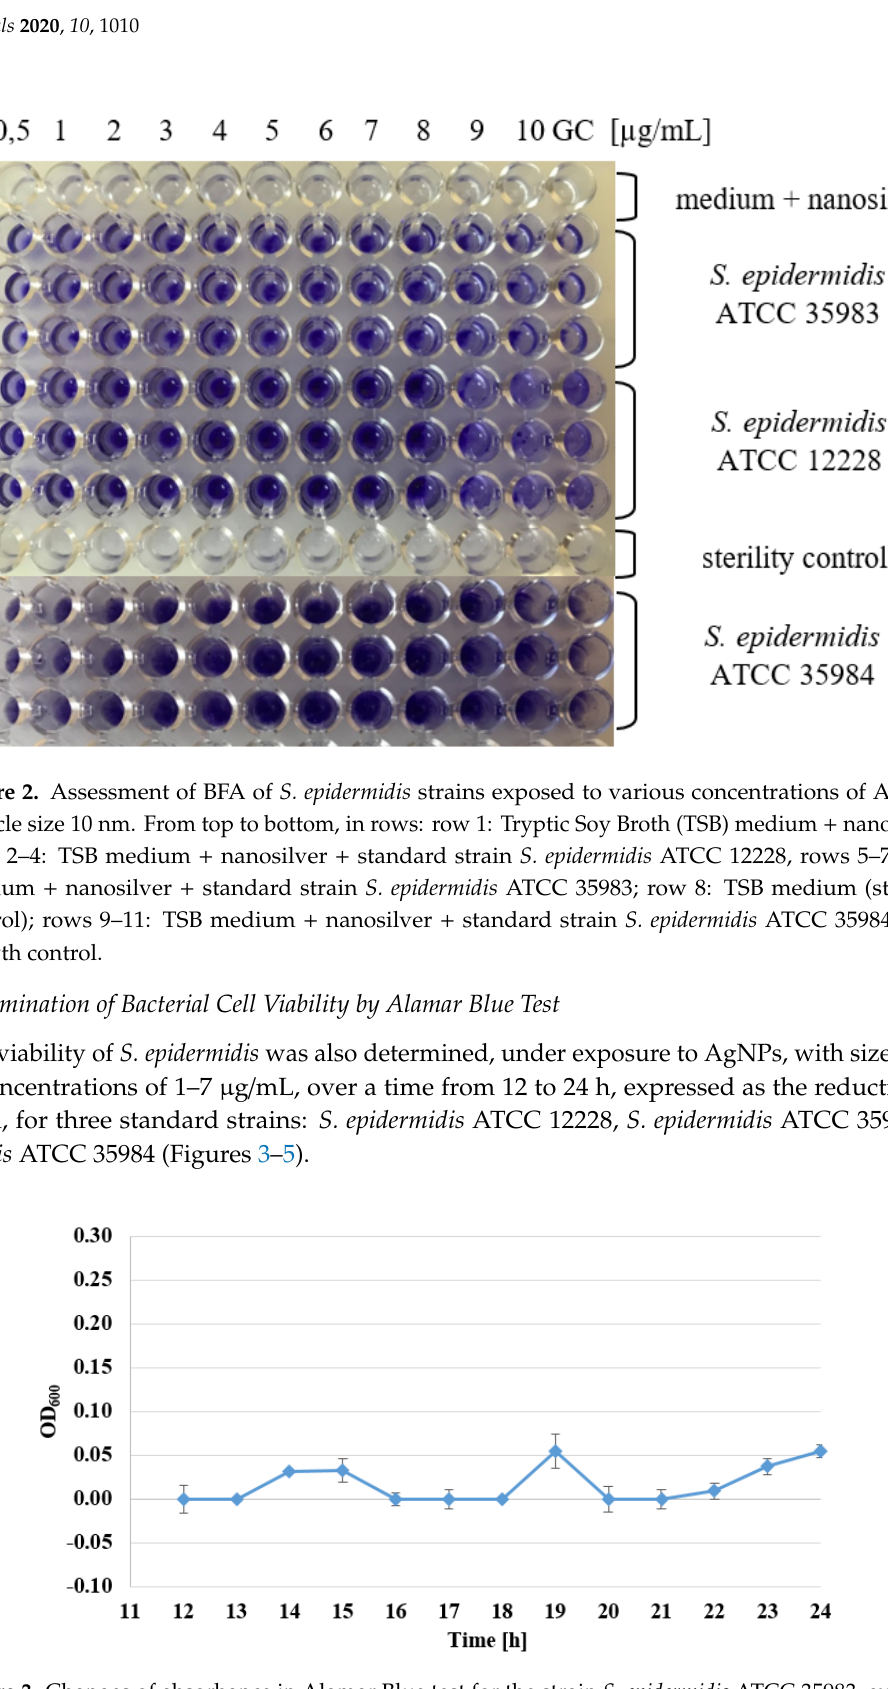
Figure 3. Changes of absorbance in Alamar Blue test for the strain S. epidermidis ATCC 35983, exposed to the activity of nanosilver particles with sizes of 10 nm and a concentration of 7 µg/mL between the 12th and 24th hour ( λ = 600 nm).